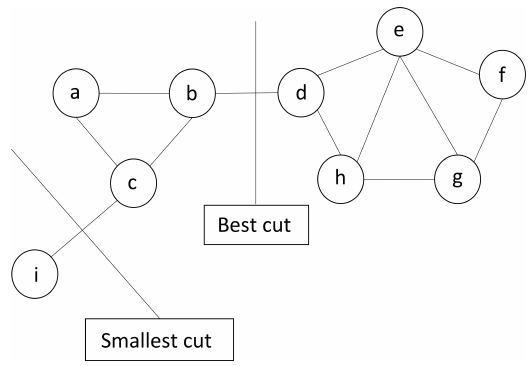
Fig. 2 Partition of